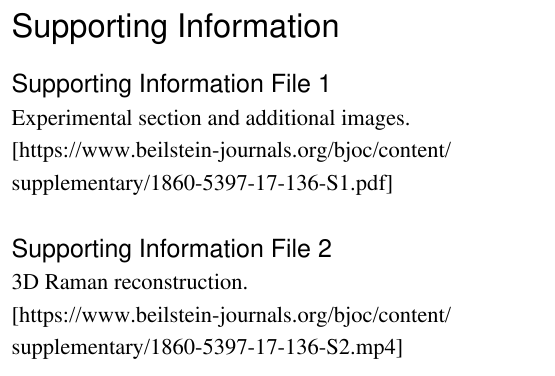
tions on larger sections of the scaffolds (Figure 3G and Figure